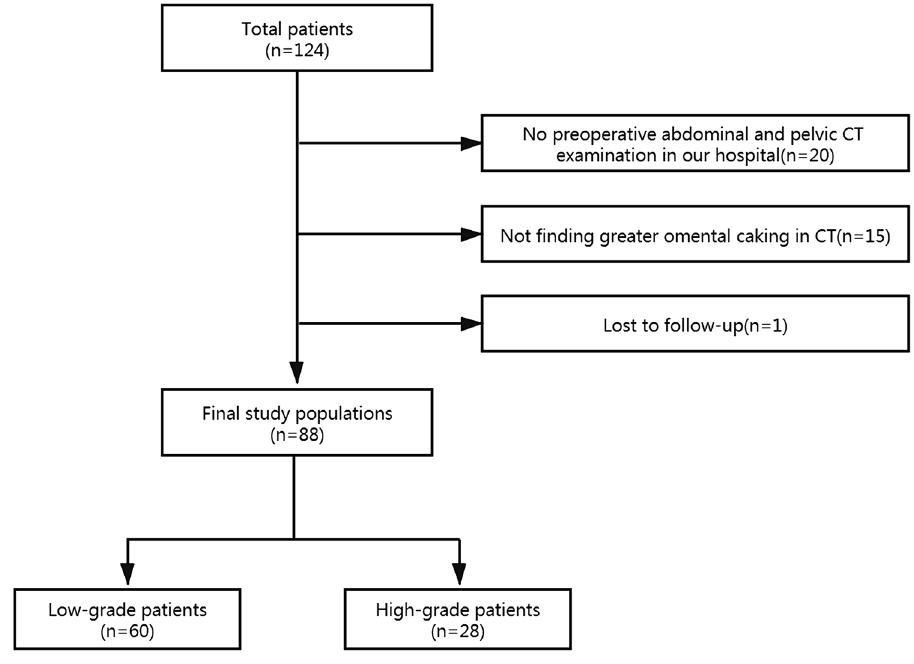
Figure 1. Patient selection flow